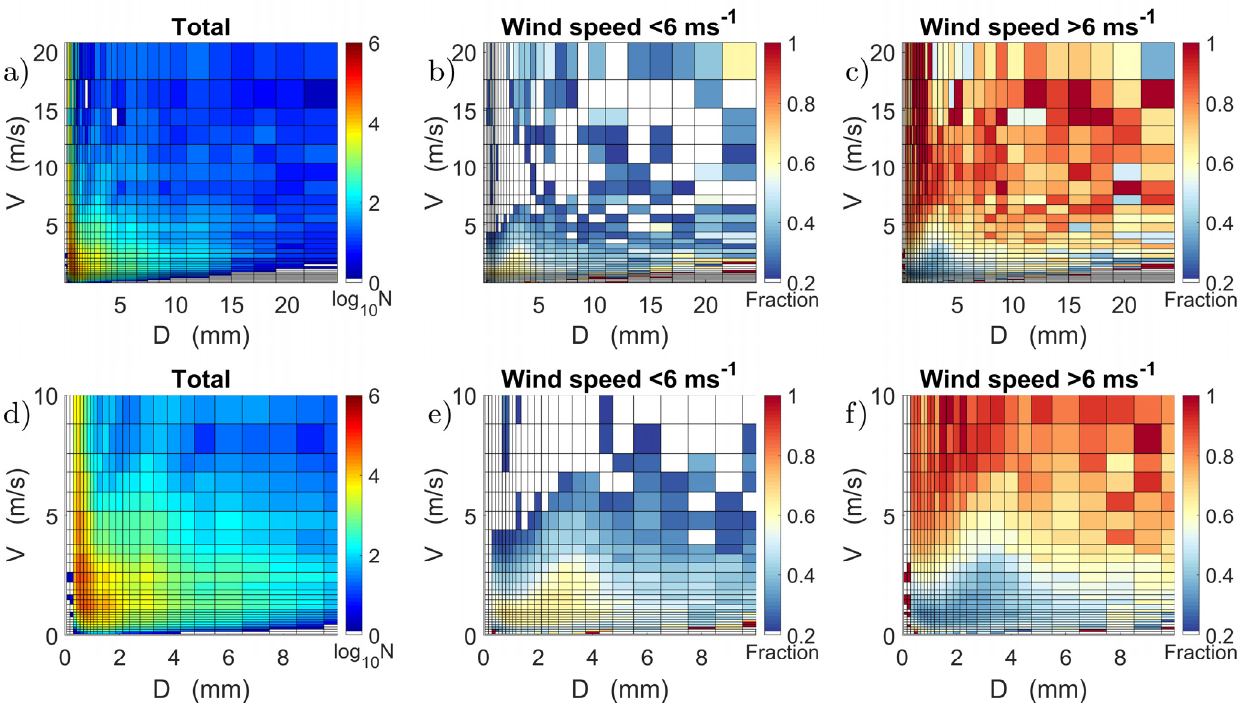
Figure 2. ( a ) Disdrometer data of the 2019 and 2020 summer seasons at MZS. In Parsivel spectrograph (fall velocity vs. diameter), colors represent the number of particles for each bin. Number of hydrometeors below ( b ) and above ( c ) the wind speed threshold (6 m s − 1 ) divided by the total number of hydrometeors detected in each bin (colors represent fraction values). ( d ), ( e ) and ( f ) as in ( a ), ( b ) and ( c ) but zoomed up to 10 mm and 10 m s − 1 for diameter and velocity values, respectively.